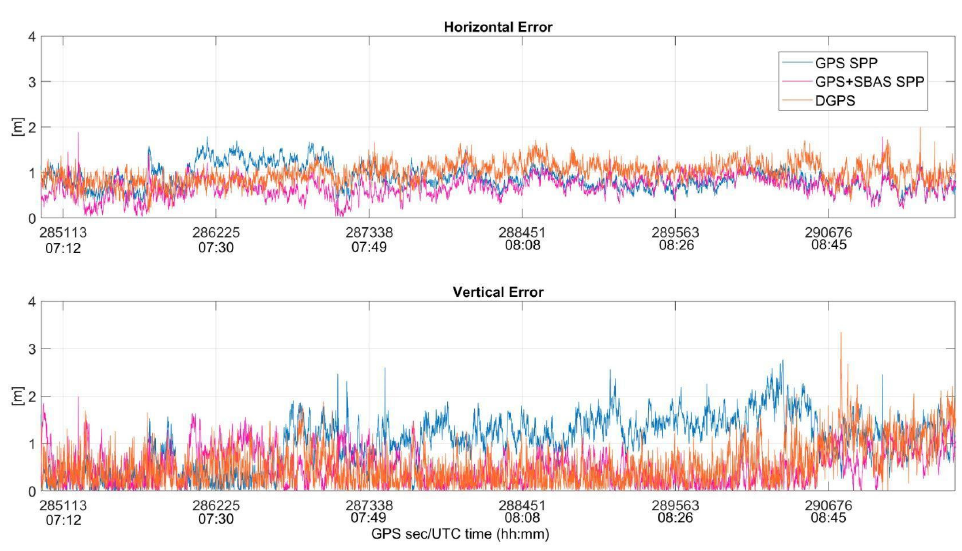
Figure 11. Horizontal and vertical positioning errors (in meters) as function of the time for GPS SPP (blue line), GPS + SBAS SPP (magenta line) and DGPS (orange line) configurations applied to data from u-blox receiver.